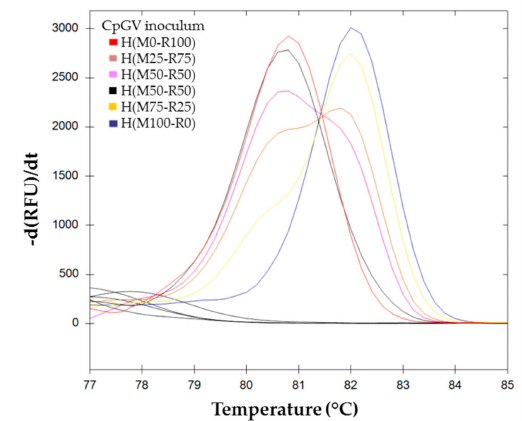
Figure 4. Melting curve analysis of pe38 amplifications using BVs obtained on larvae in conditions of mixed infection. ( ) H(M0-R100), ( ) H(M25-R75), ( ) H(M50-R50)a, ( ) H(M50-R50)b, ( ) H(M75-R25), and ( ) H(M100-R0).